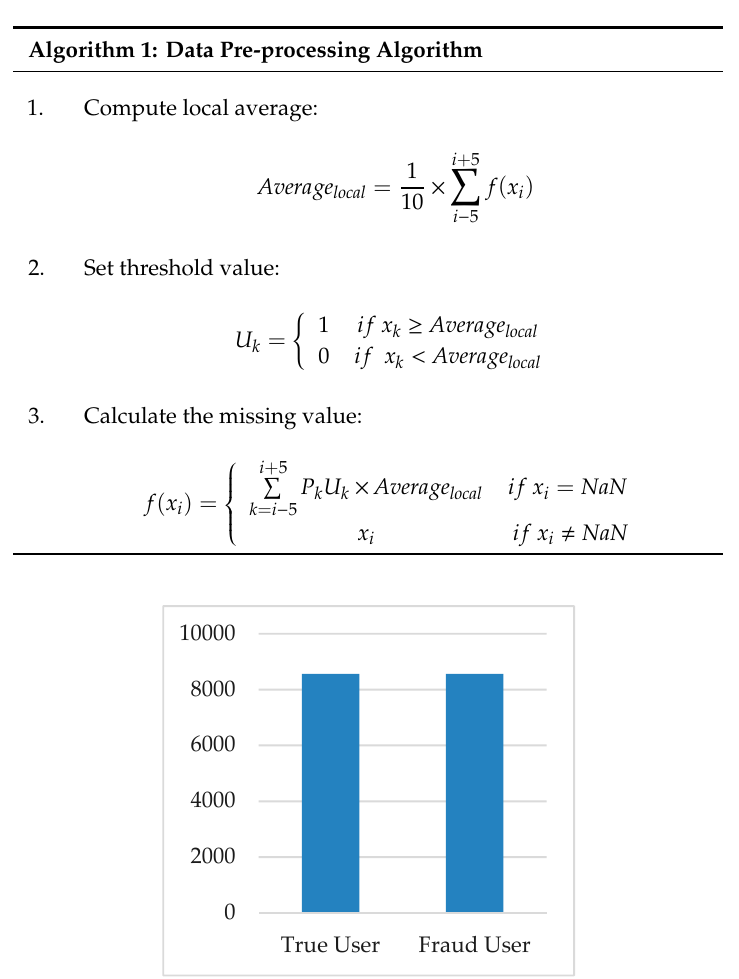
Figure 4. Distribution of normal and theft users after applying synthetic minority over-sampling technique (SMOTE).